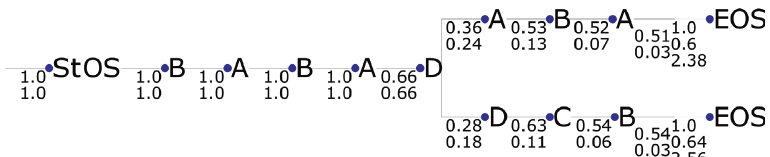
Figure 19: Output of the seq2probTree method for the tree-based system with input sequence [B A B A].